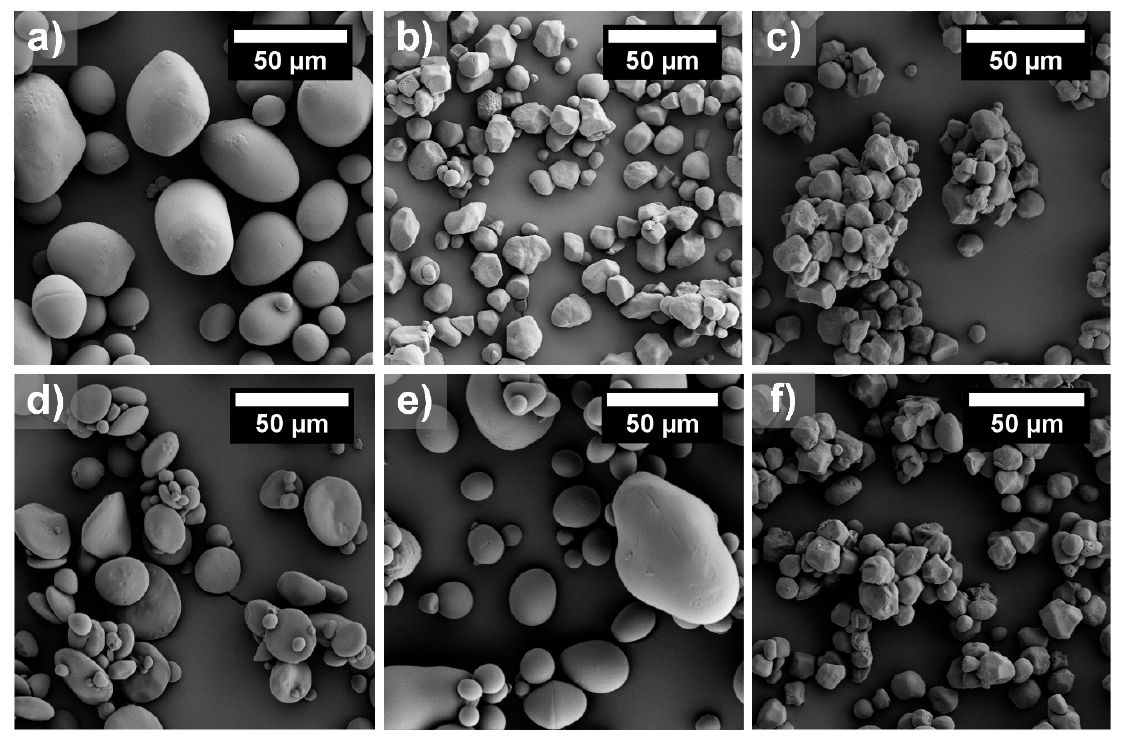
Figure 5. SEM images of ( a ) native potato starch, ( b ) native corn starch, ( c ) native waxy corn starch, ( d ) native wheat starch, ( e ) oxidized potato starch, and ( f ) oxidized corn starch.